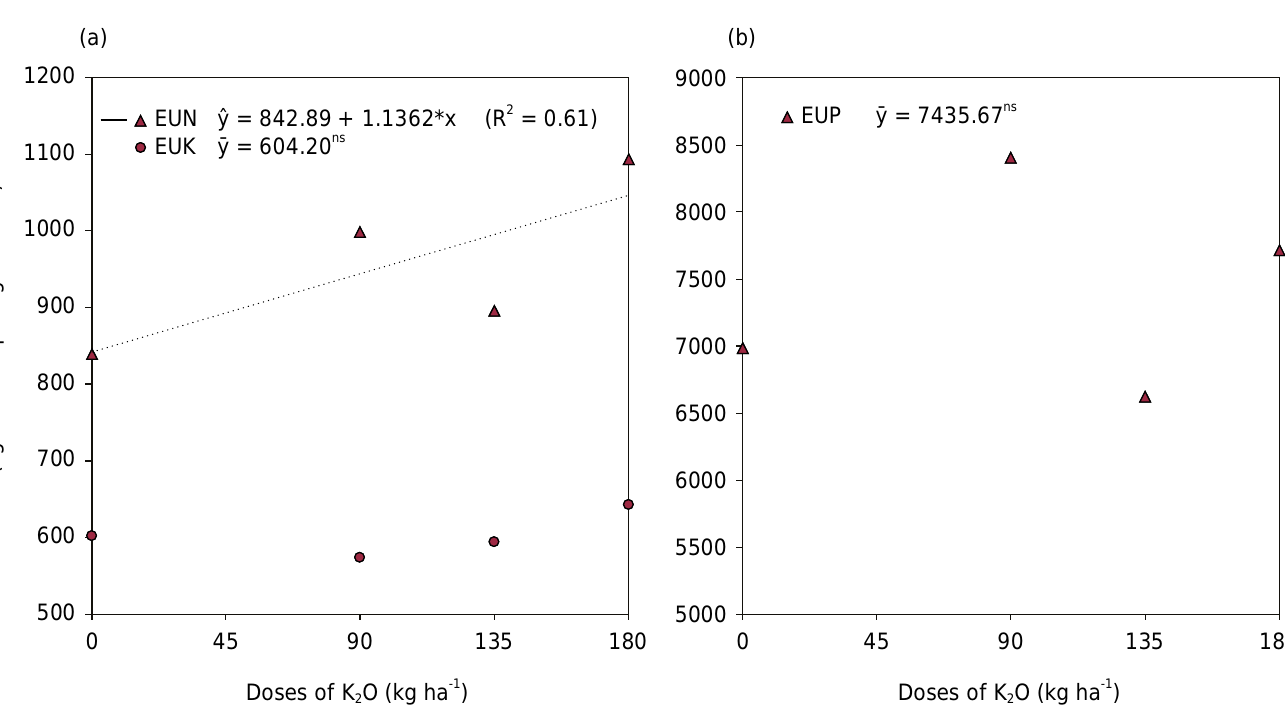
Figure 5. Efficiency of use of nitrogen (EUN), potassium (EUK) (a), and phosphorus (EUP) (b) of E. urophylla hybrid, evaluated at 66 months after planting, as a function of doses of K 2